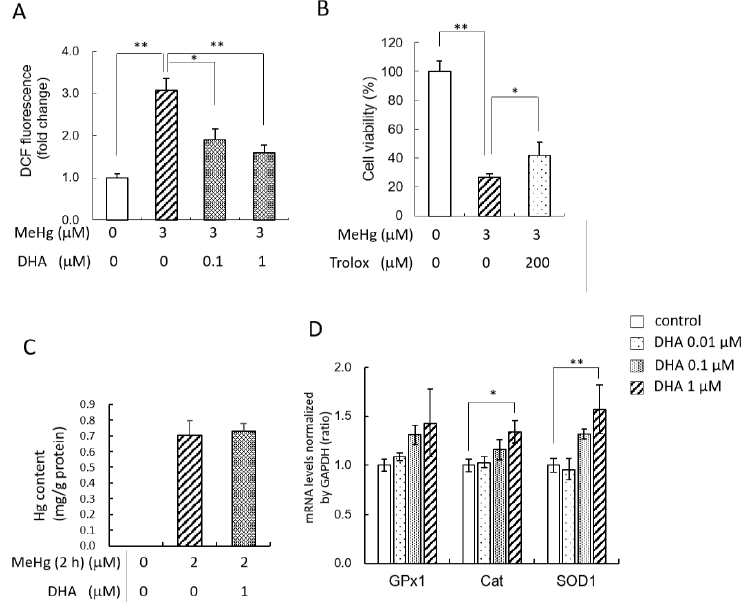
experiments. ** p < 0.01.